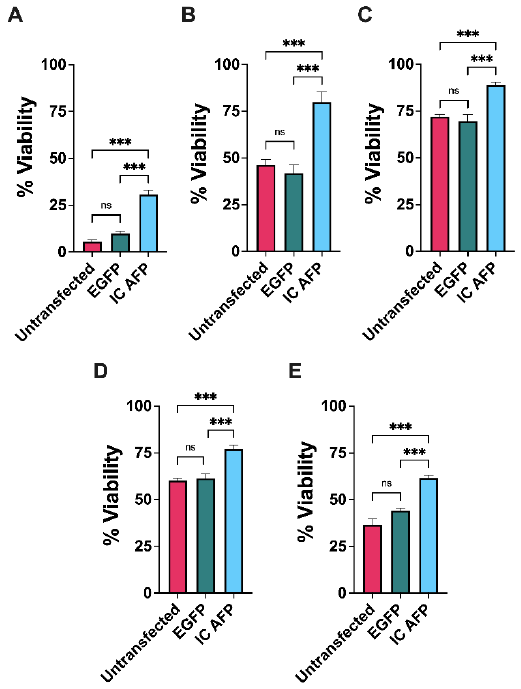
Figure 2. Analysis of cell viability by trypan blue exclusion in untransfected, EGFP-transfected, and EGFP–AFP-transfected (IC AFP) HEK 293T cells after cryopreservation. A total of 5 × 10 6 cells were cryopreserved with ( A ) 0, ( B ) 5, ( C ) 10, ( D ) 15, and ( E ) 20% ( v / v ) concentrations of dimethyl sulfoxide